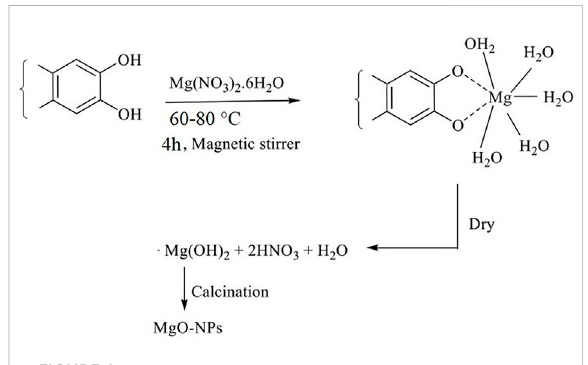
FIGURE 1 Tentative mechanism of MgONPs synthesis from pumpkin seed